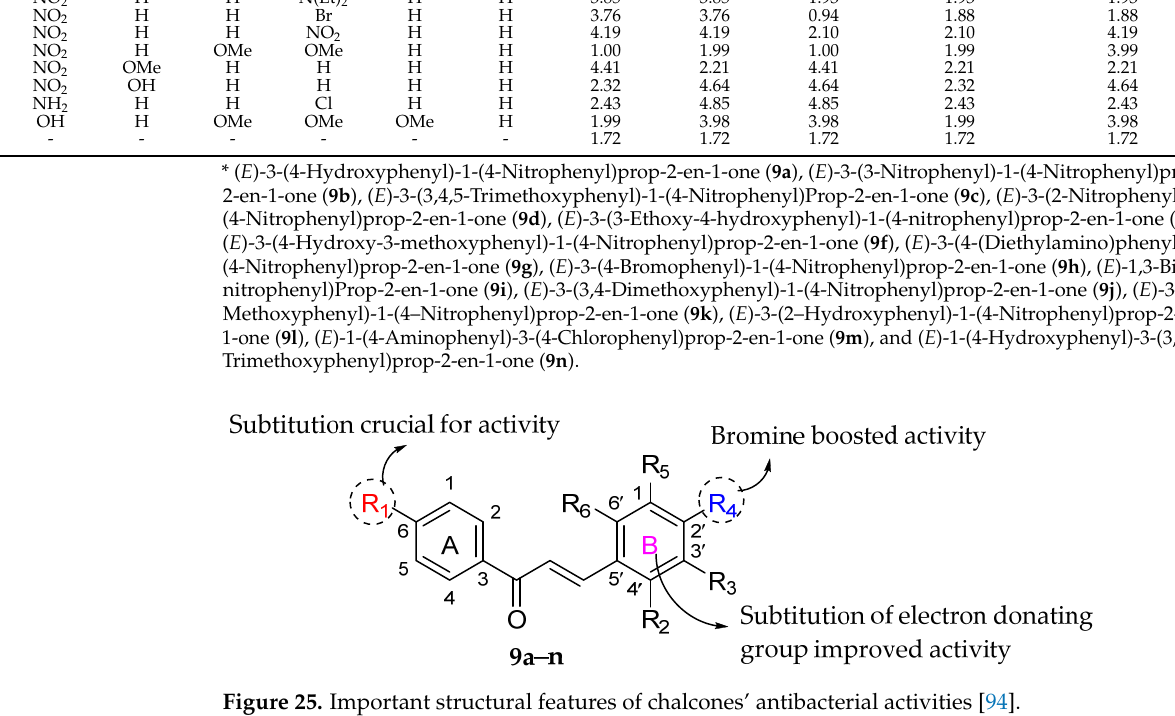
Figure 25. Important structural features of chalcones’ antibacterial activities [94]. Sadgrove et al. (2020) isolated several isoflavones and derivatives from the bark of Erythrina lysistemon . The compounds were identified as erybraedin A, phaseollidin, abys- sinone V-4 ′ methyl ether, eryzerin C, alpumisoflavone, cristacarpin, and lysisteisoflavone. These compounds’ antibacterial activity was also tested, and the findings are reported in Table 16. The authors addressed how prenylation is vital for activity because all molecules except alpumisoflavone have a prenyl group. Following that, hydroxylation at the same